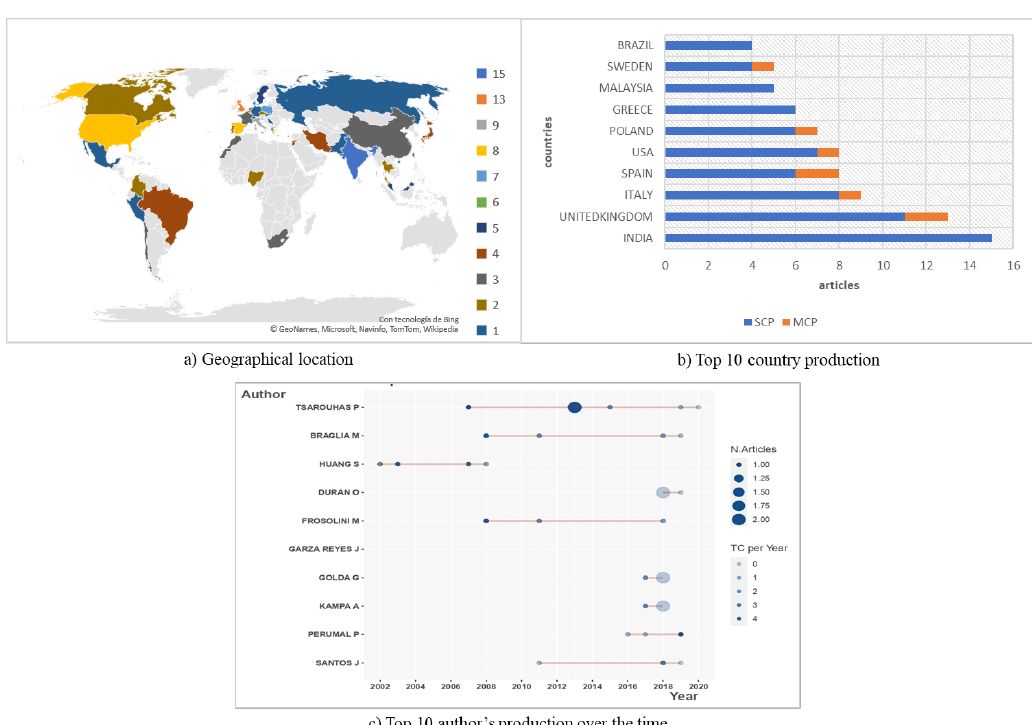
Figure 3. The effort in terms of ( a ) geographical location ( b ) top 10 country production and ( c ) authors contribution over the time.